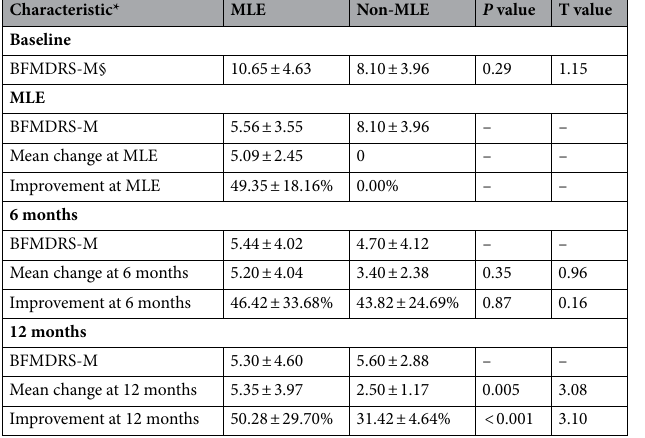
Table 2. Results of assessments per and post DBS at GPi in Meige syndrome patients with and without MLE. *Plus–minus values are means ± SD. § A higher score indicates worse